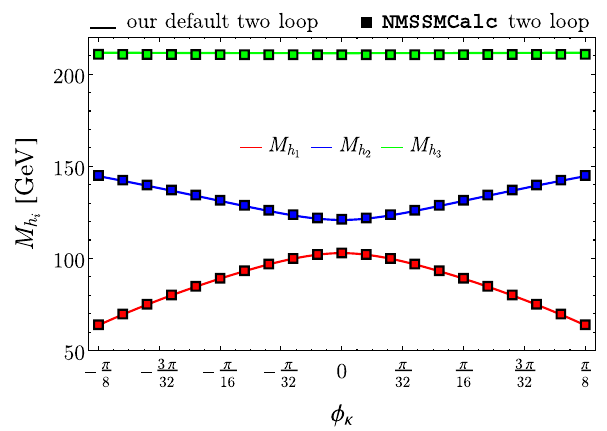
Fig. 4 Masses of the three lighter Higgs fields as a function of φ κ for the scenario λ = 0 . 7, | κ | = 0 . 1, tan β = 2, M H ± = 1170GeV, μ eff = = 0 . 5TeV, A = A = 0 . 1TeV, 500GeV, A κ = − 70GeV, m ˜ t b Q 3 , ˜ T , ˜ B 2 M 1 = M 2 = M 3 / 5 = 0 . 5TeV. The red color depicts the mass of the mostly CP -odd, singlet-like state h 1 ; blue is associated to the essentially SM-like state h 2 and green corresponds to the mostly CP - even singlet-like state h 3 . We display our “default” result for the masses ( solid curves ) as well as the predictions of NMSSMCALC ( squares )